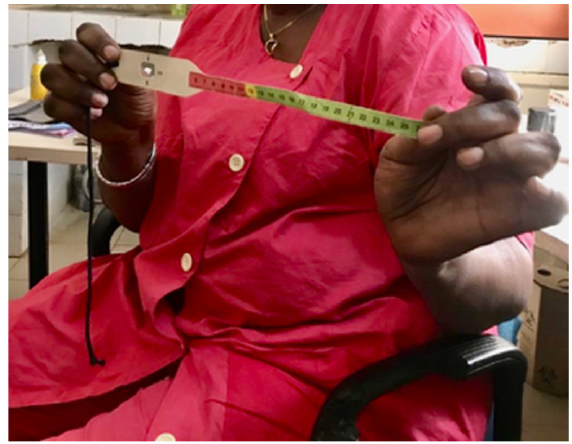
Figure 7. Nurse showing a child malnutrition assessment device.